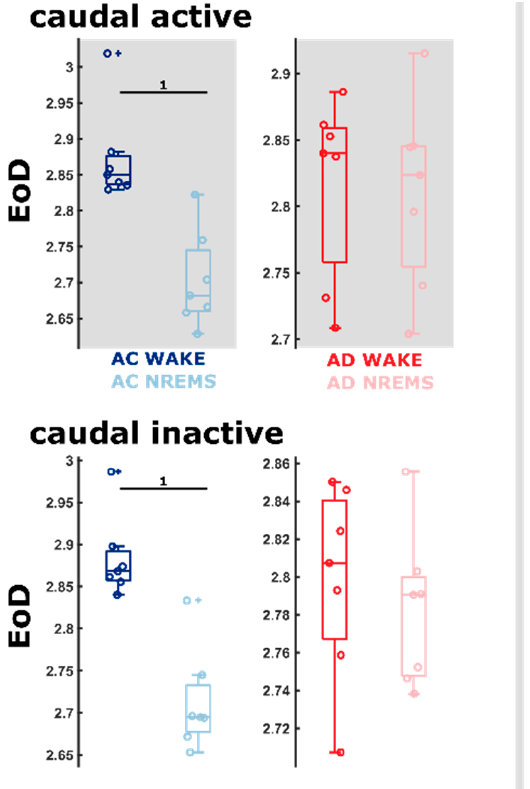
Figure 6. Comparison of entropy of difference (EoD) between WAKE and NREM sleep (NREMS). Combined box and dot plots of the EoD ( τ = 1), the comparison within groups between WAKE and NREM sleep. Blue indicates the control (AC) and red—the Alzheimer’s (AD) group. We observed significant EoD differences (as indicated by AUC) in the AC group, but not in the AD group. The “+” indicate outlier for the box plot. Table 1. Results of the AUC analysis to determine differences in the EoD ( τ = 1) between the AC group and the AD group at certain vigilance states, as well as between WAKE and NREM sleep (NREMS) in either the AC or AD animals. Bold values indicate significance.